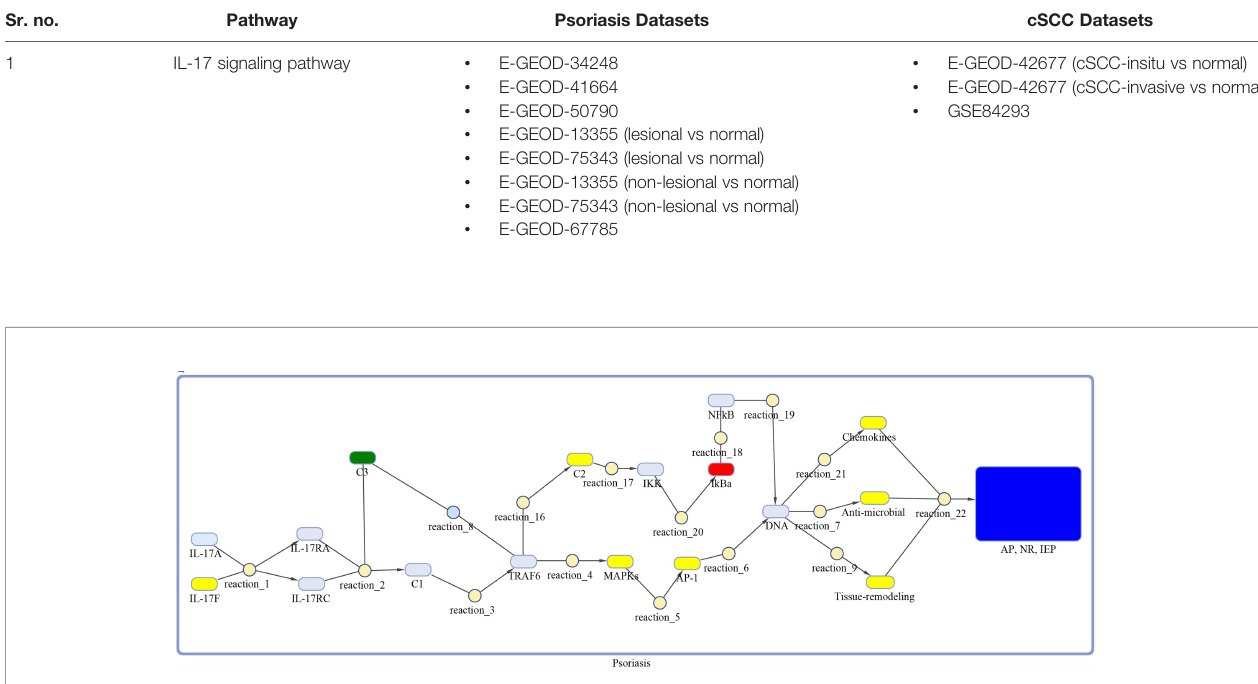
FIGURE 3 | Model of IL-17 signaling pathway for psoriasis. The model is built as network of species (oval) and reactions (circle), which are connected by edges. Species represent biological entities of the pathway, and are color coded. Dark blue color shows processes of autoimmune pathology, neutrophil recruitment, and immunity to extracellular pathogens, yellow color depicts DEGs, green color shows DEG that are also acting as inhibitor, red color shows inhibitors, and sky-blue color represents genes that are part of the pathway, however, not differentially expressed. The species MAPKs includes MAPK13 and MAPK14. Chemokines includes CXCL1, CXCL2, CXCL5, CXCL8, CXCL10, CCL2, CCL7 and CCL20. The species Anti-microbial includes S100A7, S100A8, S100A9, and LCN2 genes. Tissue remodeling includes MMP1 and MMP9 genes. C1, C2, C3 and AP-1 are complexes of genes. C1 includes Hsp90 and Act1. C2 includes TAB2, TAB3 and TAK1 genes. C3 incorporates ANAPC5 and A20 genes, and AP-1 includes FOSL1 and FOS genes.